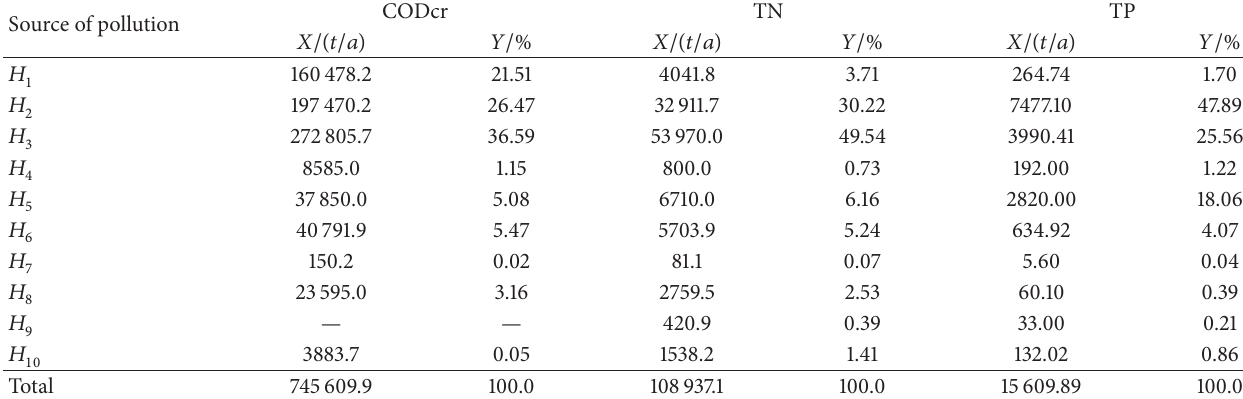
Table 2: Pollutant discharge amount of Taihu Lake area in